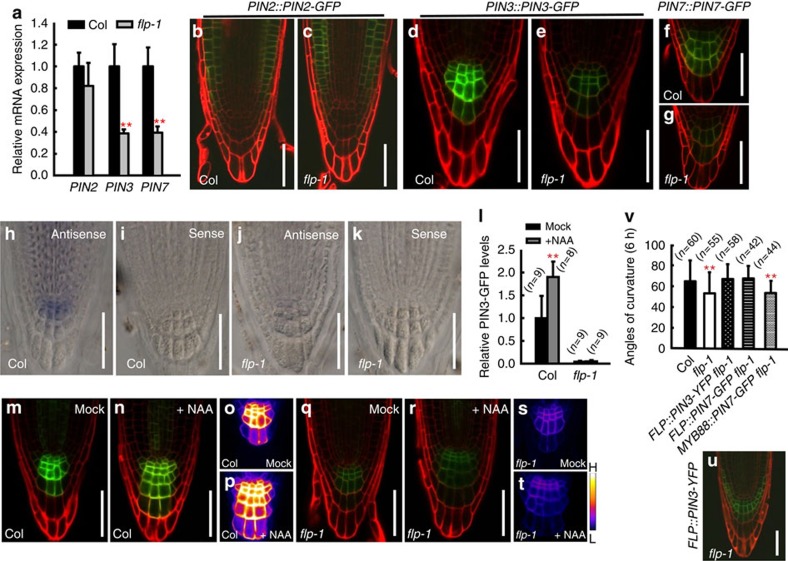
Downregulation of PIN3 and PIN7 transcription in flp roots.(a) Real-time qPCR analysis of multiple PIN genes in flp-1 mutant roots. Transcript levels of PIN3 and PIN7 are significantly reduced in flp-1 roots. However, PIN2 transcript levels are only slightly reduced in flp-1. Asterisks indicate significant differences between Col and flp-1 (Student's two-tailed t-test; **P<0.01; three individual experiments, 50 mg dissected roots). Normal expression pattern of PIN2::PIN2-GFP in Col (b) and flp-1 (c) root epidermal and cortical cells but no GFP signals in gravity-sensing cells. (d–g) Expression of PIN3::PIN3-GFP and PIN7::PIN7-GFP was reduced in flp-1 columella cells (e,g) compared with that in respective Col background (d,f). (h–k) Whole-mount in-situ hybridization of PIN3 mRNA. PIN3 mRNA was detected in wild-type columella, predominantly in the C1 and C2 layers (h). PIN3 mRNA was barely detected in flp-1 (j). Negative PIN3 sense controls for wild-type (i) and flp-1 (k). (l) Relative fluorescence intensities of PIN3-GFP in gravity-sensing cells after NAA treatment (0.5 μM NAA, 4-day-old). Col display a significant enhancement of PIN3-GFP signals. However, overall PIN3-GFP level in flp-1 roots is not upregulated by auxin. Asterisks indicate significant differences (Student's two-tailed t-test; **P<0.01 compared with respective mock controls; three individual experiments; n, number of roots scored for each genotype). (m–t) PIN3-GFP expression in Col is upregulated by auxin (m,n). No obvious enhancement of PIN3-GFP expression in flp-1 (q,r). Heat map images (o,p,s,t). (u) Expression of FLP::PIN3-YFP in a flp-1 root tip. (v) Expression of PIN3-YFP and PIN7-GFP driven by the FLP promoter fully rescues gravitropic defects in flp-1 primary roots. By contrast, PIN7-GFP under the control of the MYB88 promoter is unable to rescue flp-1 phenotypes. Asterisks indicate significant difference (Student's two-tailed t-test; **P<0.01 compared with Col; three individual experiments; n, number of roots scored for each genotype). Bars in a,l,v represent mean values with s.d. Red fluorescence in b–g,m,n,q,r,u derives from propidium iodide staining that shows cell outlines. Scale bars, 50 μm.